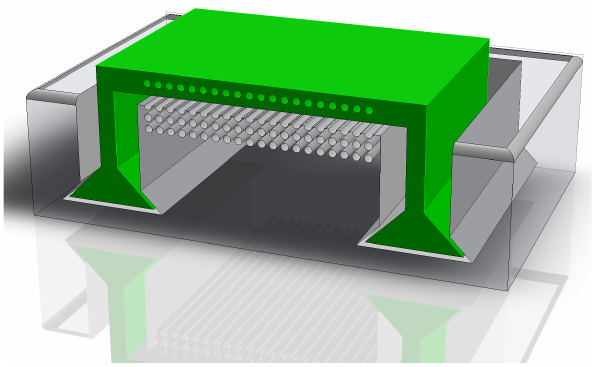
Figure 1. Conceptual design of a 2DOF capacitive force sensor. The green part is flexible. Holes represent position of conductive wire (Shemelya et al.,